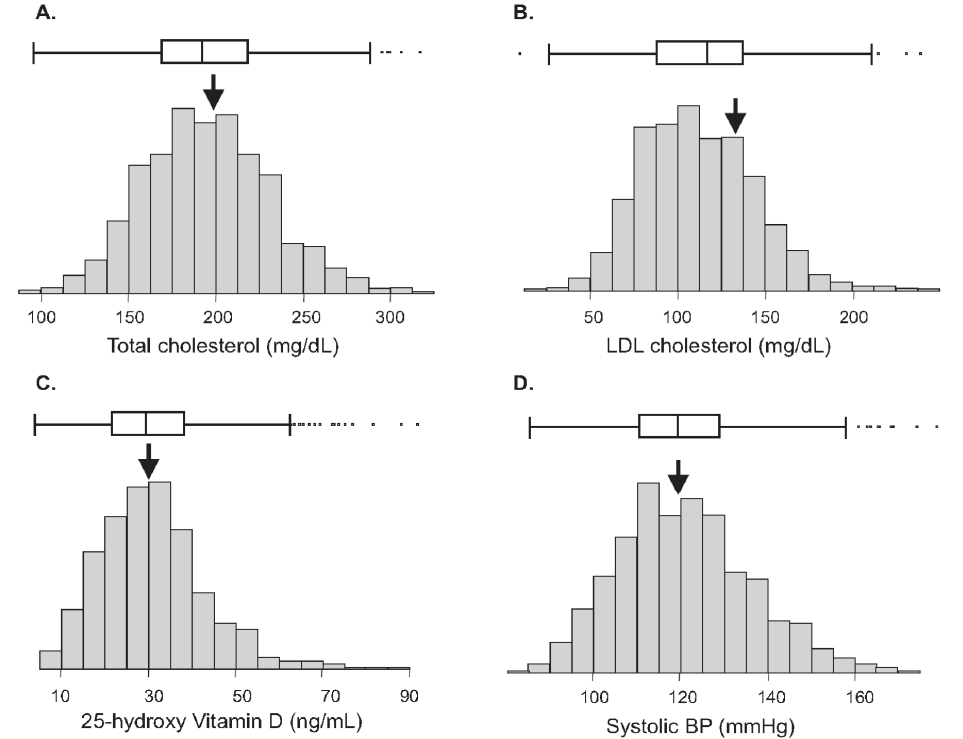
Figure 1. Distribution of cardiovascular risk factors in The Center for Health Discovery and Wellbeing (CHDWB) cohort at baseline. Arrows indicate reference mean for US population at large. Box and whisker show 1 and 2 standard deviations from the mean. Frequency distribution histograms are for ( A ) Total cholesterol, ( B ) LDL cholesterol, ( C ) Vitamin D, and ( D ) systolic blood